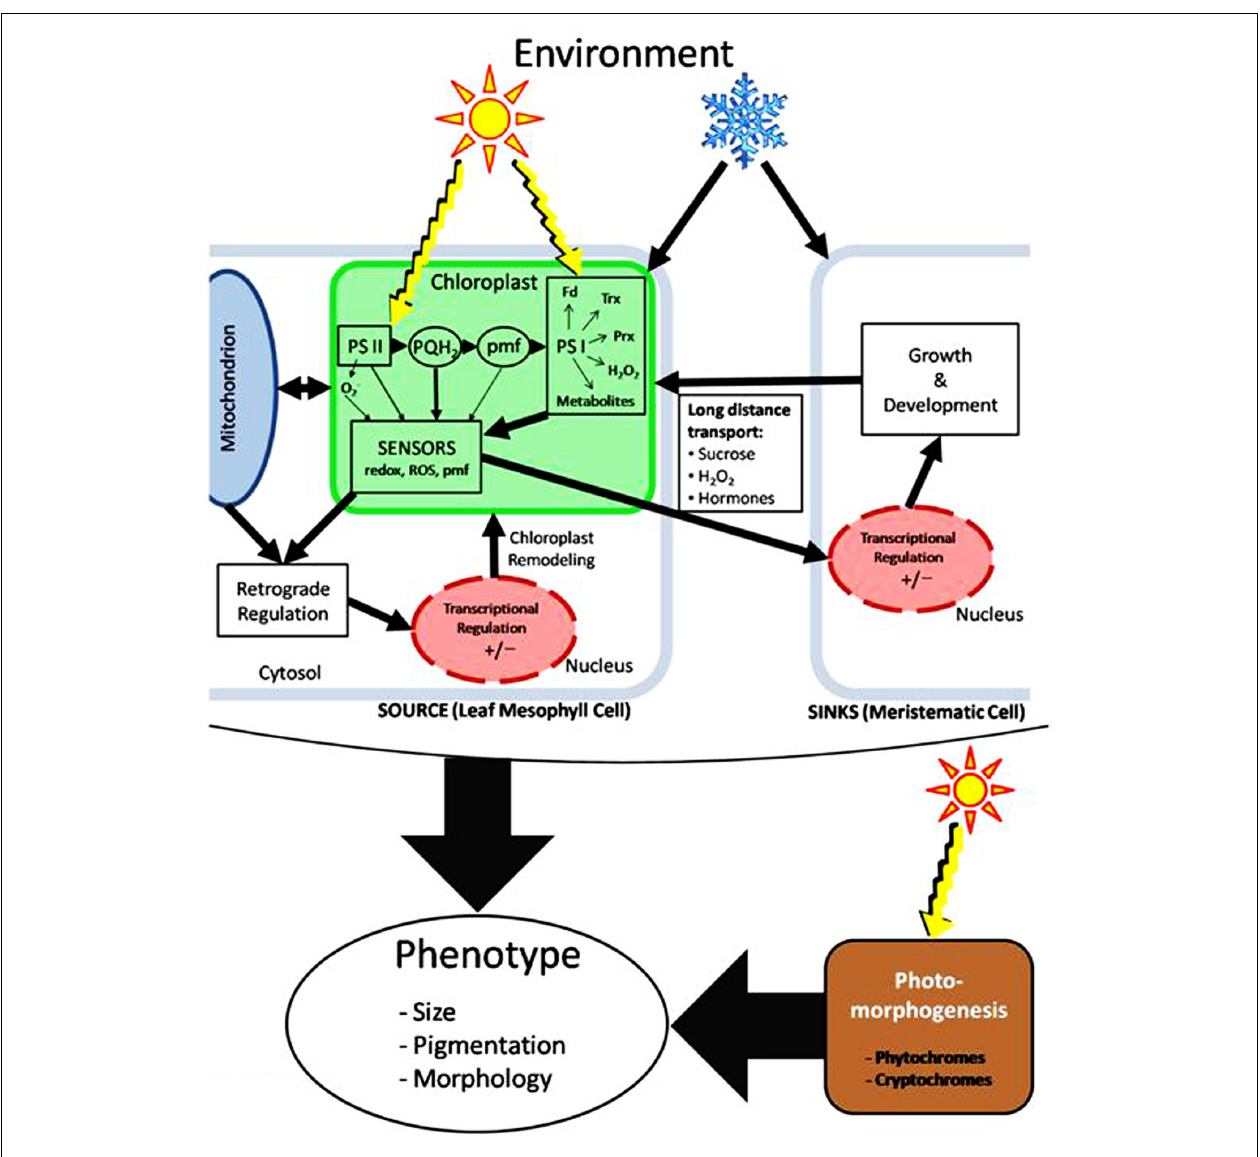
certain algae and cyanobacteria. In vascular plants, information regarding chloroplast redox imbalance is also conveyed to distant sinks such